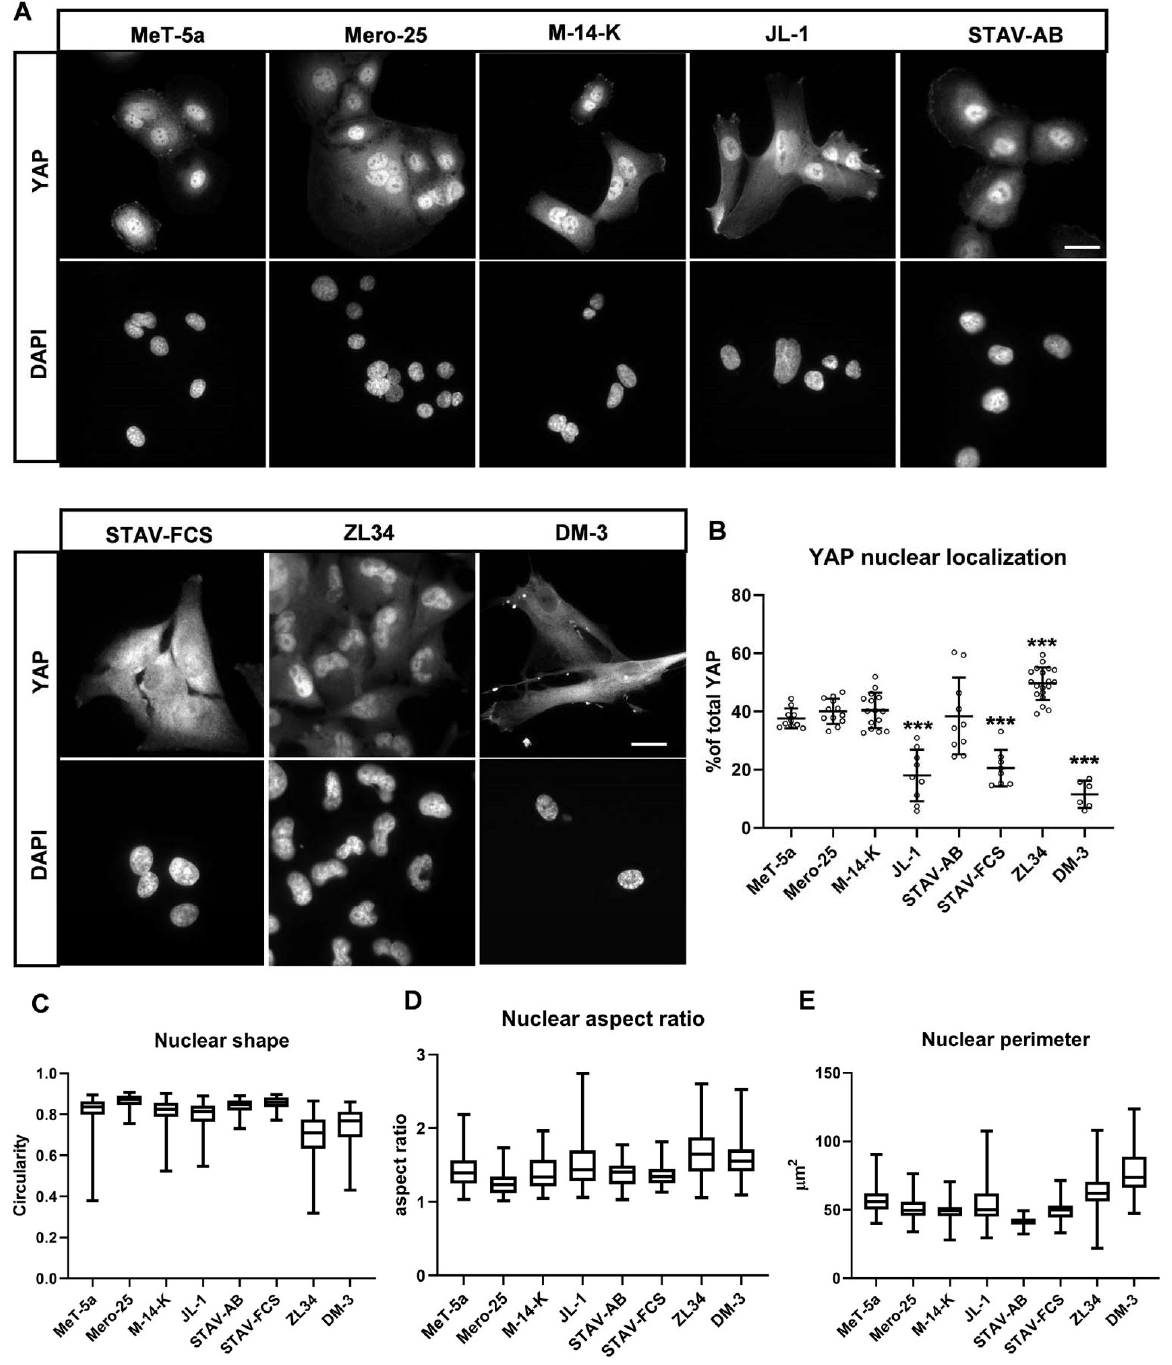
Figure 7. YAP nuclear localization and nuclear shape. ( A , B ). Representative images ( A ) and quantification ( B ) of YAP nuclear localization analyzed by immunofluorescence microscopy after visualization with a mouse anti-YAP antibody followed by an AlexaFluor488-conjugated anti-mouse antibody. Nuclei were visualized with DAPI. Scale bar, 20 µm. The Proportion of nuclear YAP nuclear YAP over the total cellular YAP was deduced from the microscopy images using ImageJ. MeT-5a ( n = 10), Mero-25 ( n = 12), M-14-K ( n = 15), JL-1 ( n = 9), STAV-AB ( n = 8), STAV-FCS ( n = 8), ZL34 ( n = 19), DM-3 ( n = 6). ( C – E ). Quantification of nuclear shape (circularity, C), aspect ratio (D) and perimeter (E) was performed by ImageJ. MeT-5a ( n = 72), Mero-25 ( n = 62), M-14-K ( n = 92), JL-1 ( n = 68), STAV-AB ( n = 77), STAV-FCS ( n = 50), ZL34 ( n = 94), DM-3 ( n = 59). One-way ANOVA with Tukey’s post hoc analyses were made to calculate statistical significances of the data in panel ( B – E ). *** = p < 0.001 mark the statistical significant difference compared to MeT-5a. A complete list of the significances of the data is presented in Table